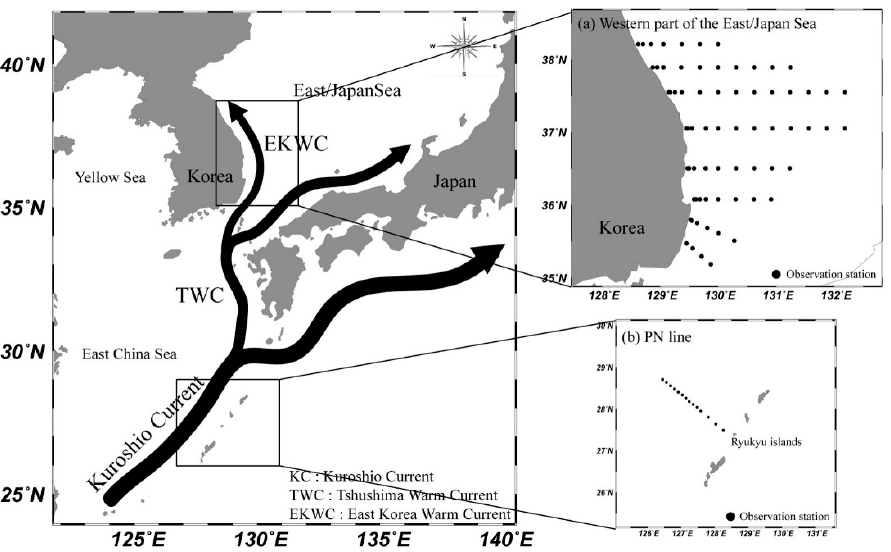
Figure 1. Study areas for sea water temperature and salinity analyses in (a) the western part of East/Japan Sea and (b) East China Sea (PN line).